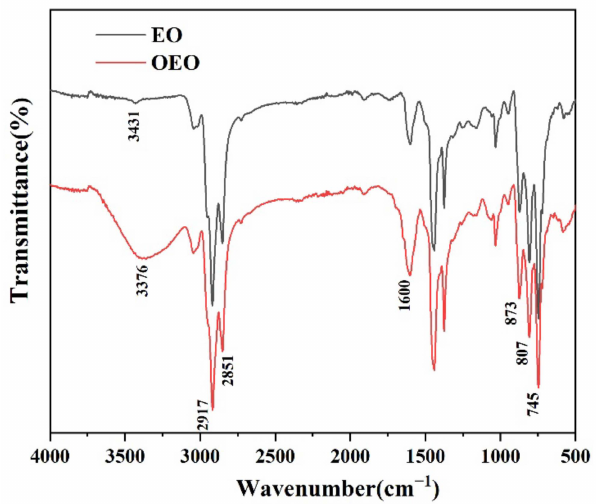
Figure 3. FTIR spectra of extraction oil (EO) and oxidized extraction oil (OEO).